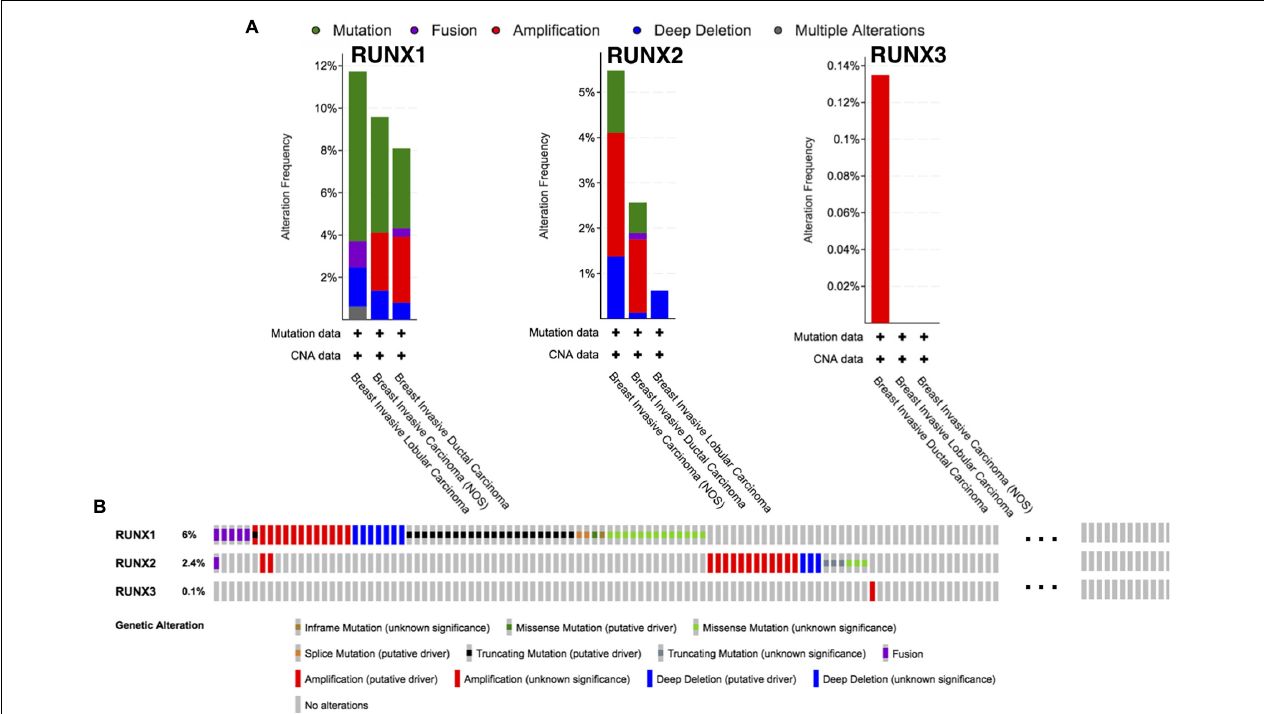
FIGURE 5 | Runt-related transcription factor alternation analysis in breast cancer. (A) The proportions of various RUNX alternations in different subclasses of breast cancer. (B) The genetic alternations of RUNX1, RUNX2, and RUNX3 in breast cancer patients.